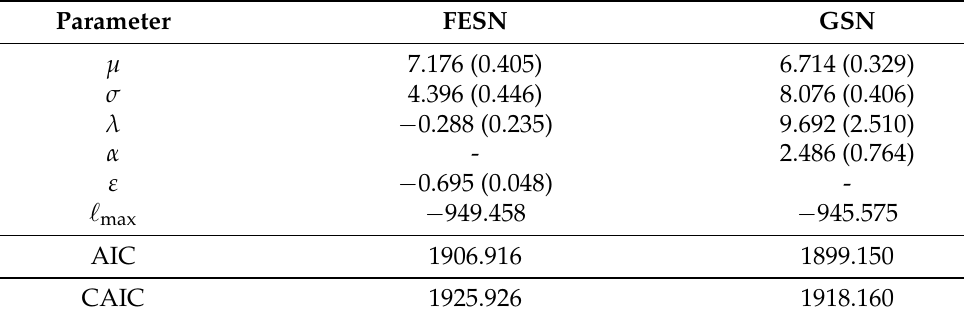
Table 4. Parameter estimates (SE) for FESN and GSN